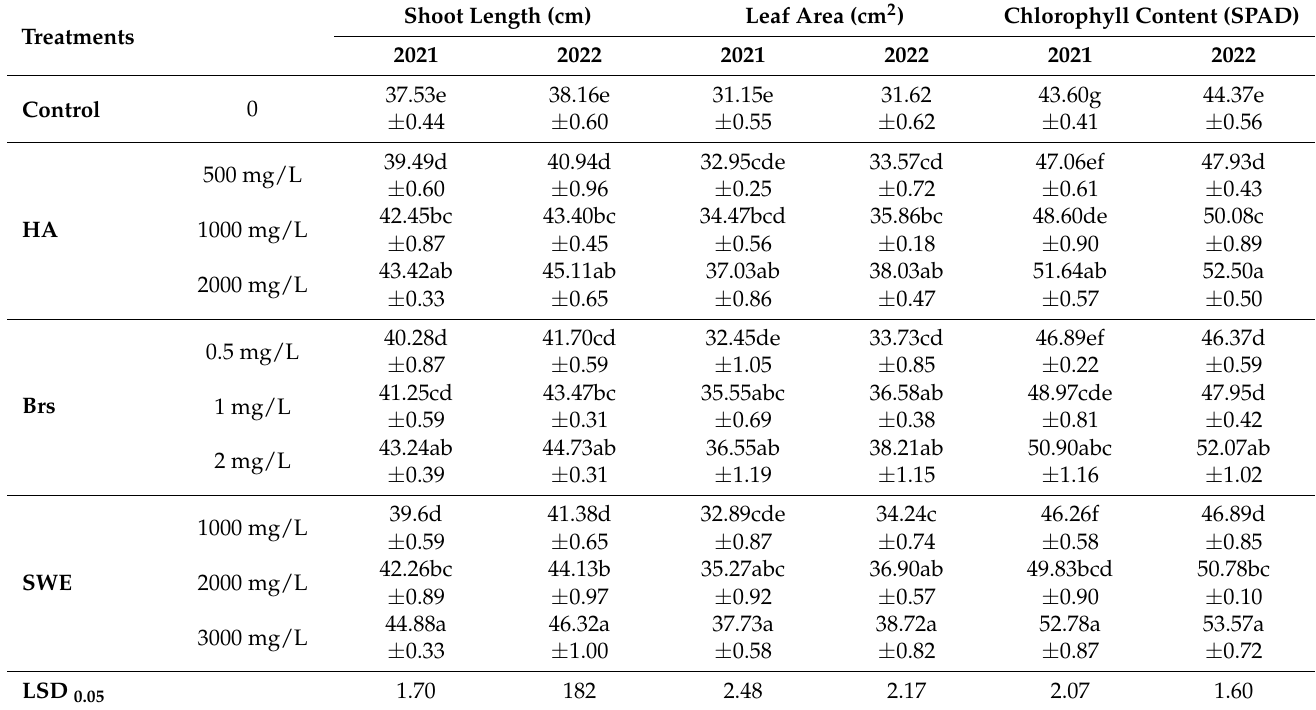
Table 4. Effect of foliar spraying of HA, Brs, and SWE on shoot length, leaf area, and leaf chlorophyll content for apricot cv. Canino during